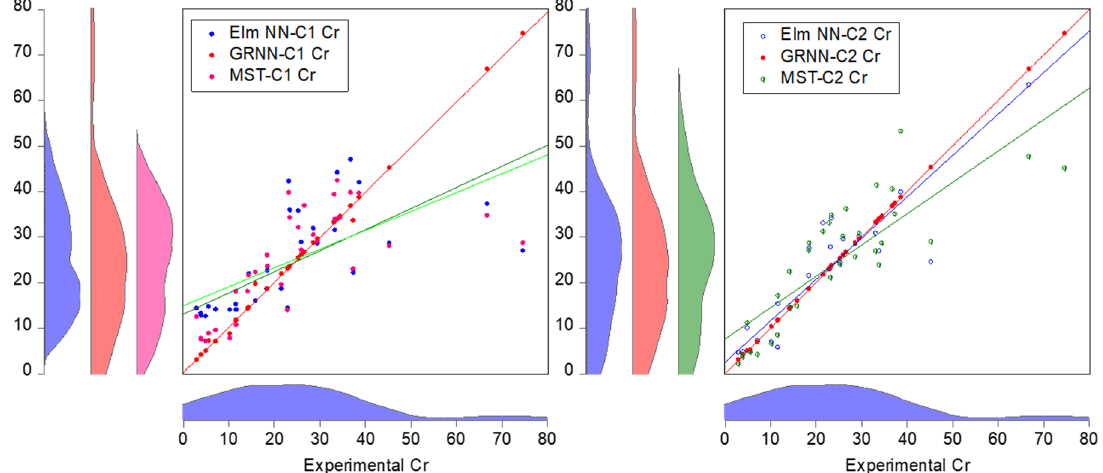
Figure 9. Scatter plots of the GPRNN, Elm NN, and MST for both C1 and C2.